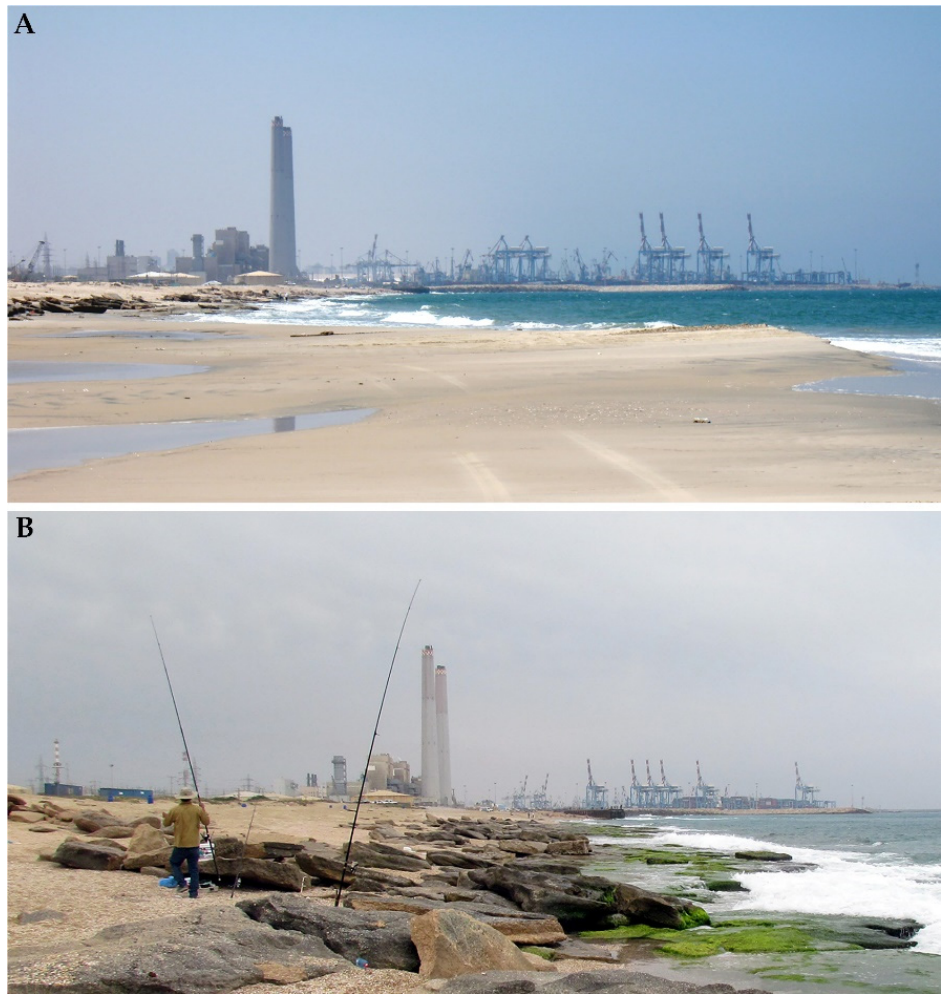
Figure 13. Beachrock coast north of Ashdod Port ( A ) during nourishment operation (May–August 2011) and ( B ) in May 2012 (photograph by Dov Zviely).